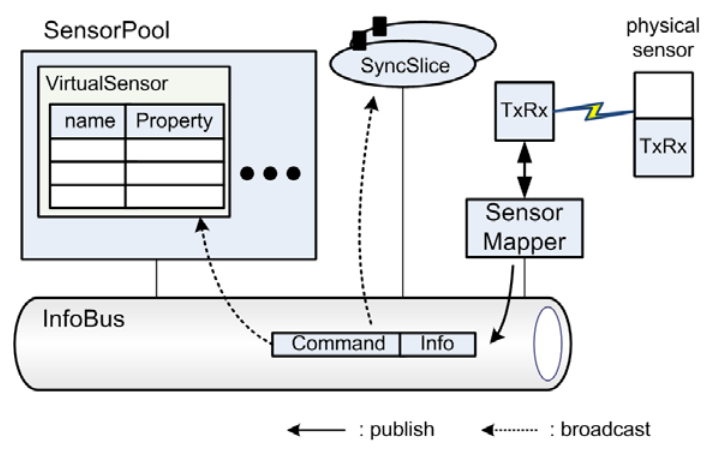
Figure 5. Message delivery through InfoBus .